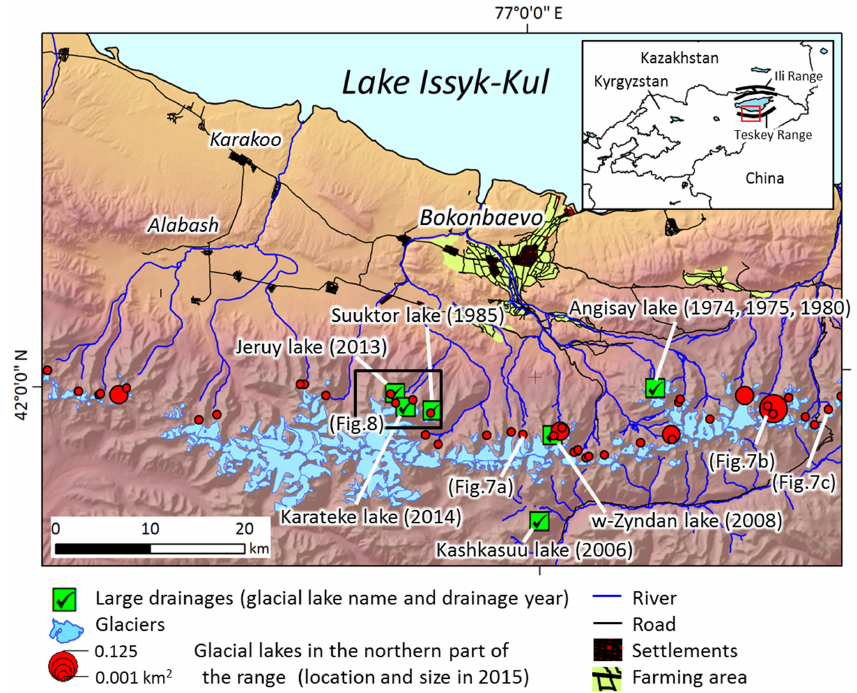
Figure 1. The study area in the western part of the Teskey Range, Kyrgyzstan. Green boxes show the location of large drainage events with their name and flooding years labelled. Location and size of red circles show locations and size of lakes in